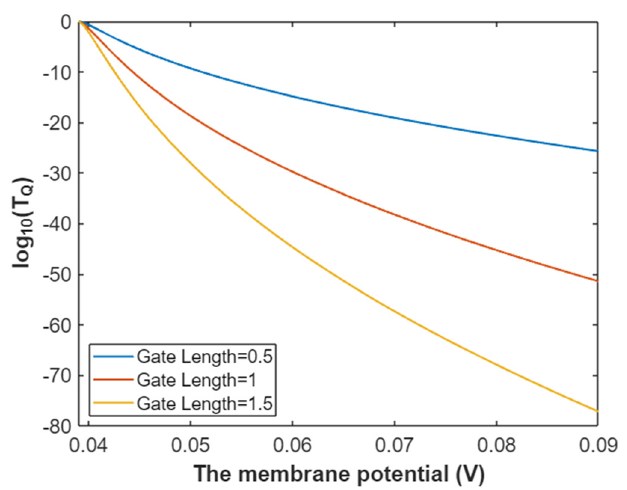
Figure 22. The relationship between membrane potential and the common logarithm of tunneling probability of intracellular potassium at G = 5.35 J and over a membrane potential range from 0.039 V to 0.09